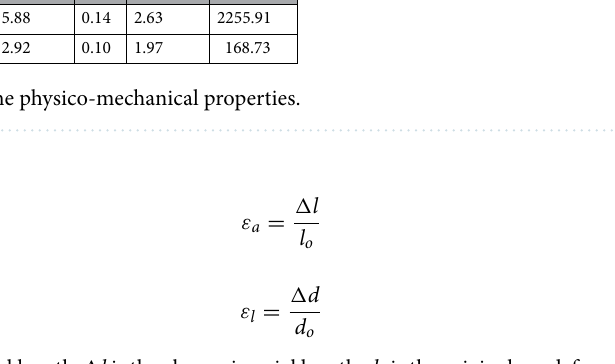
Table 1. Summary of the physico-mechanical properties.